Question: What type of chart is this?
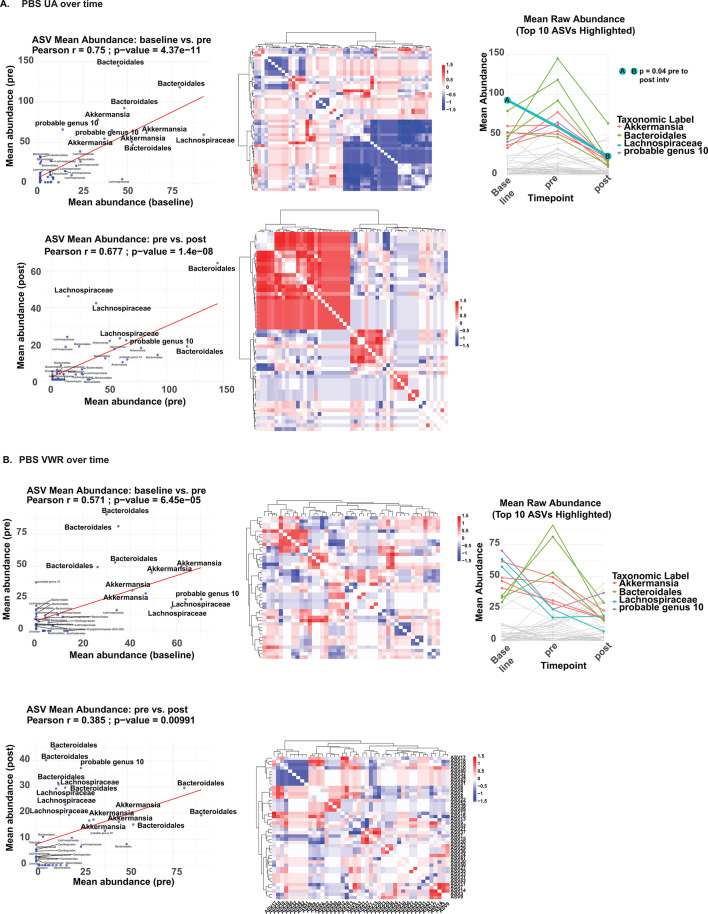
Answer: scatter